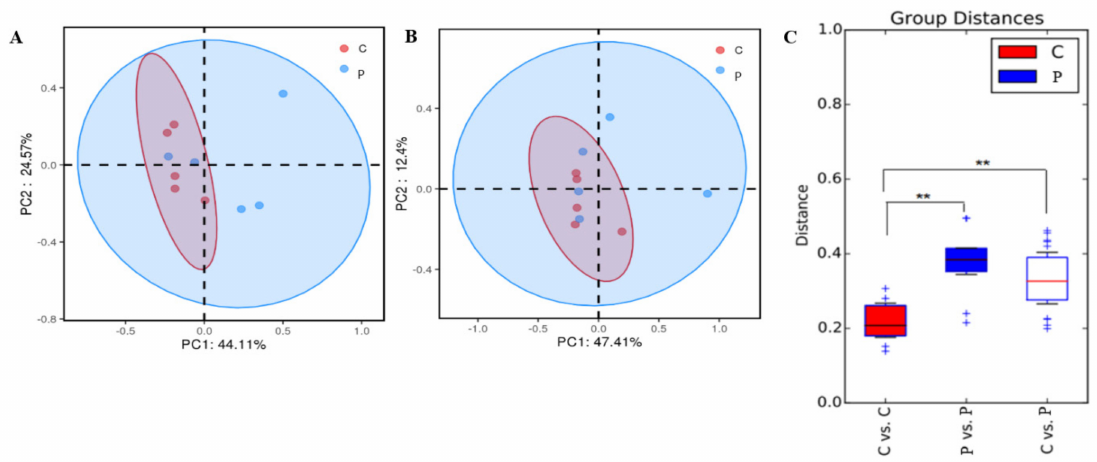
Figure 4. Dimension reduction analysis. ( A ) Principal coordinate analysis (PCoA) of weighted UniFrac distances of 16S rRNA genes. ( B ) Principal coordinate analysis (PCoA) of unweighted UniFrac distances of 16S rRNA genes. ( C ) UniFrac distance matrix plot. The pink circles represent the control group, while the blue circles represent the probiotic group. **: the difference between the control and probiotic groups was extremely significant ( p <